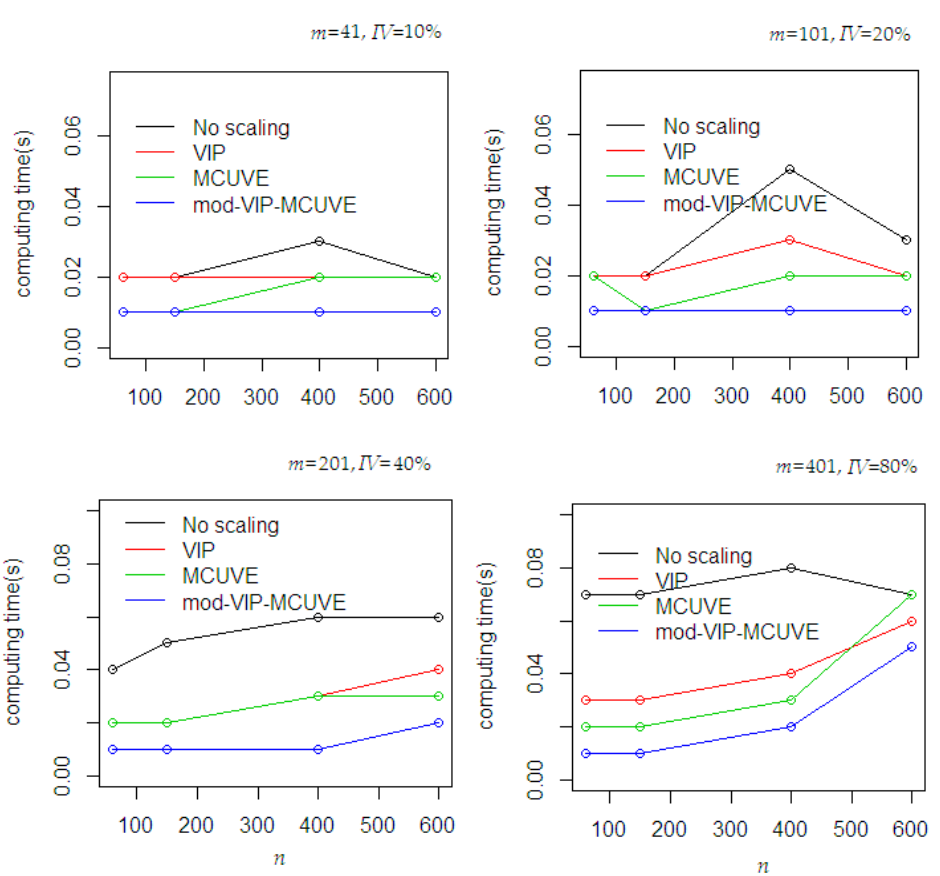
Figure 3. Time-consuming performances between methods during the fitting process using different dataset scenarios ( n = number of samples, m = number of predictors, IV = number of important variables).